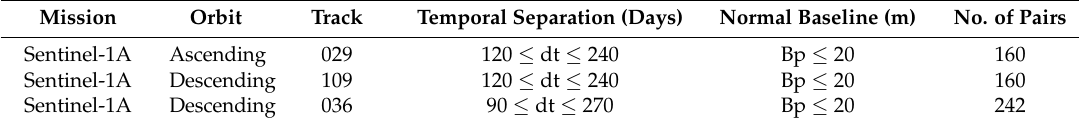
Table 2. Interferometric pairs considered in Sentinel-1 MT-InSAR